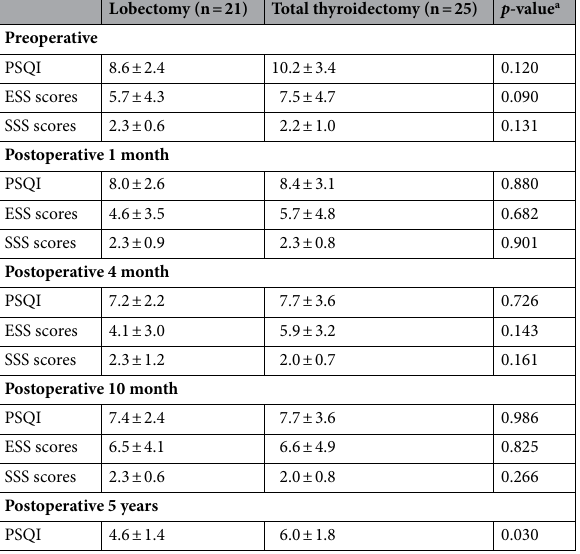
Table 2. Pre- and post-operative sleep disturbance scores in lobectomy and total thyroidectomy groups. PSQI Pittsburgh sleep quality index, ESS Epworth sleepiness scale, SSS Stanford sleepiness scale. a p -values from the Mann–Whitney U test between lobectomy and total thyroidectomy groups.